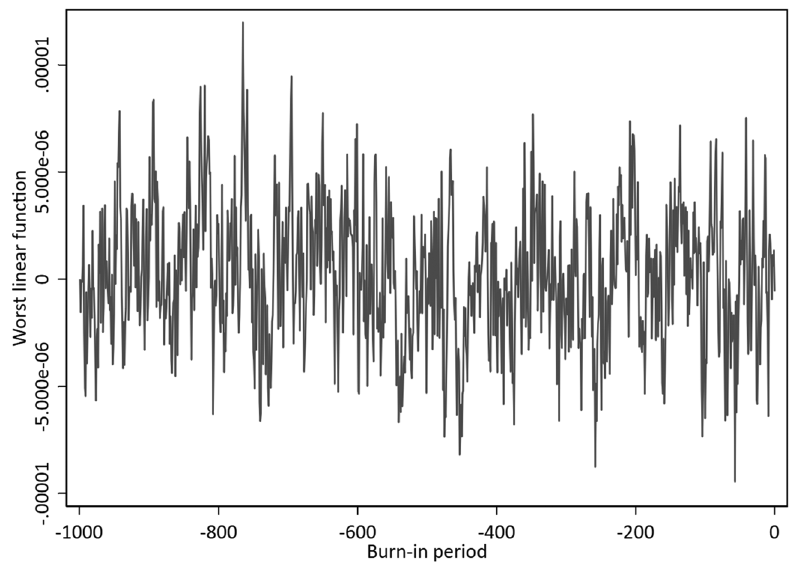
Table 4, the associated total numbers of imputations were 196 for the life expectancy regression and 167 for the infant mortality regression.